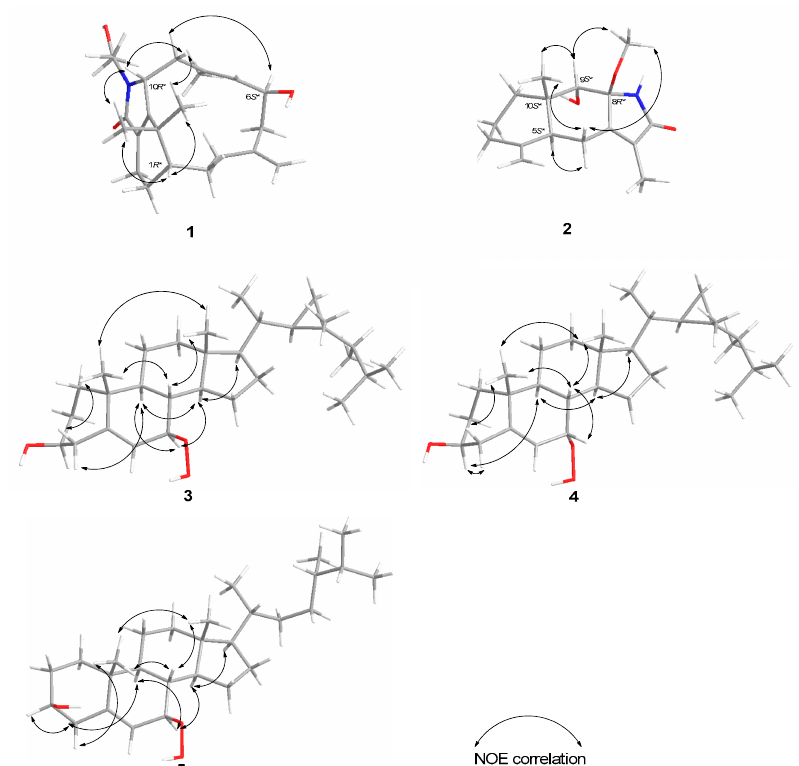
Figure 3. Selected NOE correlations of 1 – 5 .